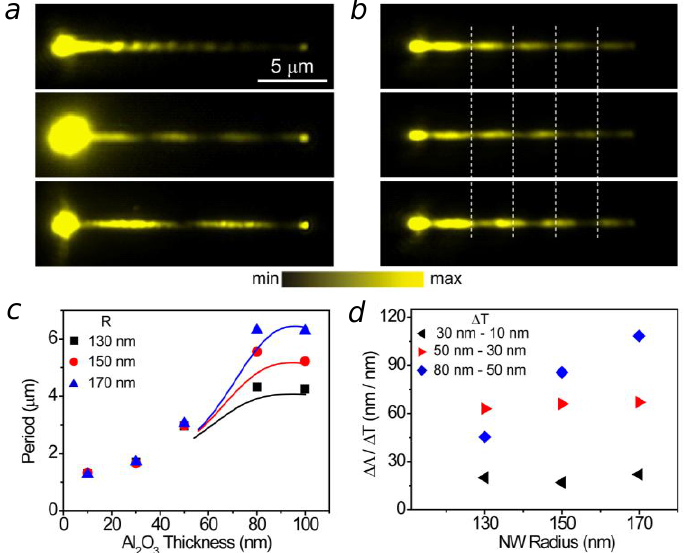
Figure 5. ( a ) QD emission images for a 155 nm radius NW coated with 15 nm of Al and QDs measured in air (Top), water (Middle), and oil (Bottom); ( b ) QD emission images for a 162 nm radius NW with a 50 nm Al O coating measured in air (Top), and then after 2 3 depositing 5 nm of Al O (Middle), and finally with an additional 5 nm of Al 2 3 The white dashed lines are visual guides to show the shift of the plasmon near-field pattern. Scale bar in ( a ) is for ( b ) as well; ( c ) The beat period as a function of Al O coating thickness. The dots are experimental data, and the lines are calculated data; 2 3 ( d ) The period change per nanometer of Al O as a function of the nanowire radius 2 3 (Adapted from